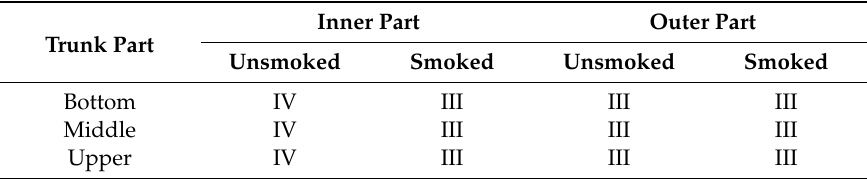
Table 7. Resistance class after exposed to dry-wood termite.